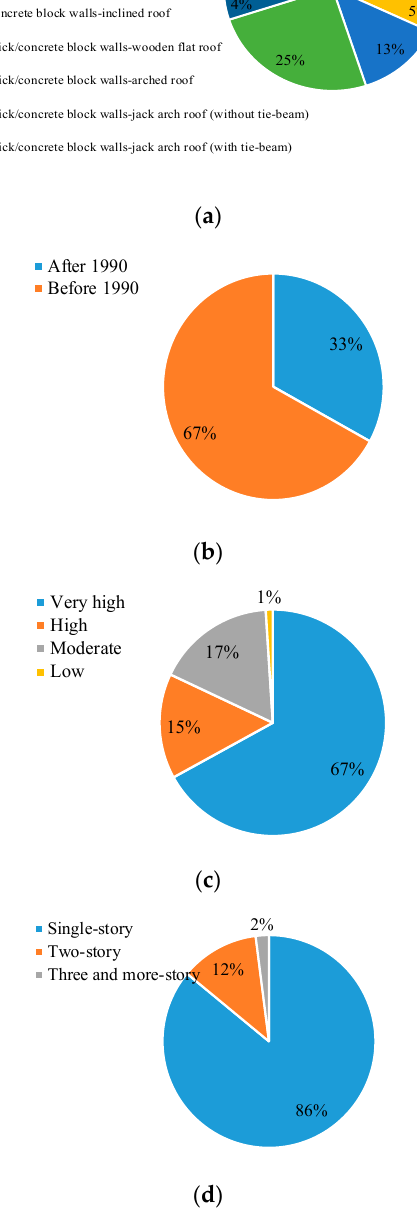
Figure 1. ( a ) Taxonomy of the Iranian residential buildings in rural areas [24]; ( b ) Year of construction of Iranian masonry school buildings [31]; ( c ) Scattering of Iranian masonry school buildings based on site seismicity [31]; ( d ) Number of stories in Iranian masonry school buildings